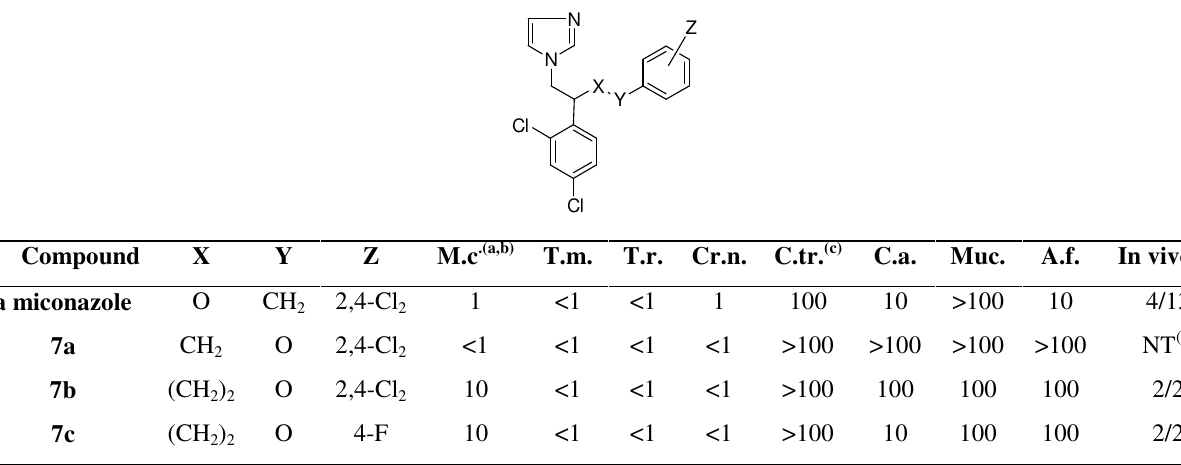
Table 2. In vitro and in vivo antifungal activity and in vitro antibacterial activity of some close miconazole analogues